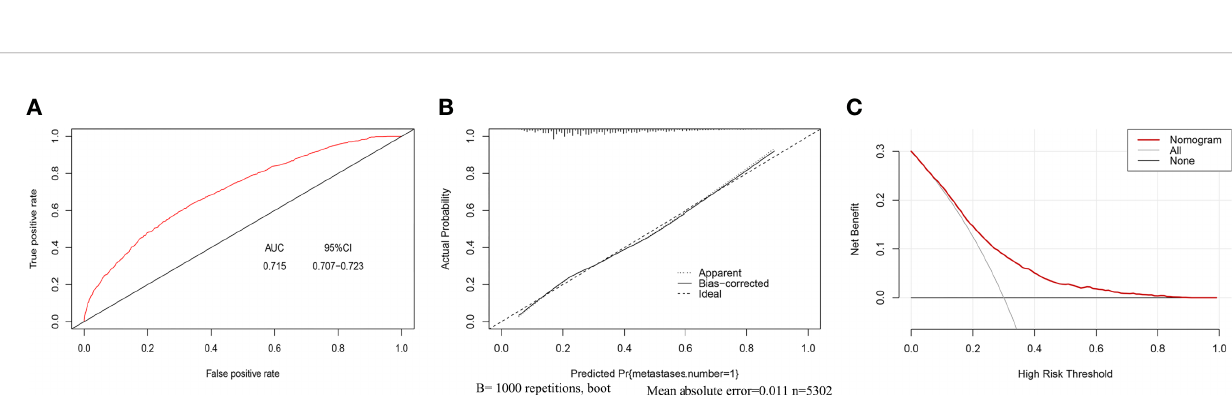
FIGURE 5 | AUC values of ROC predicted multiple metastases (A) . The calibration curve of predictive nomograms for predicting multiple metastases (B) . Decision curve analysis of the predictive nomogram for predicting multiple metastases (C) . (panel A ) AUC, Area under the curve; 95CI%, 95% con fi dence interval. (panel B ) Apparent, Calibration curve of nomogram without bootstrap adjustment; Bias-corrected, Calibration curve of nomogram with 1,000 bootstrap adjustment; Ideal, Ideal calibration curve; (panel C ) Nomogram: The bene fi t curve represented by the nomogram; All: Net bene fi t curve when all samples are multiple metastases; None: Net bene fi t curve when all samples are single